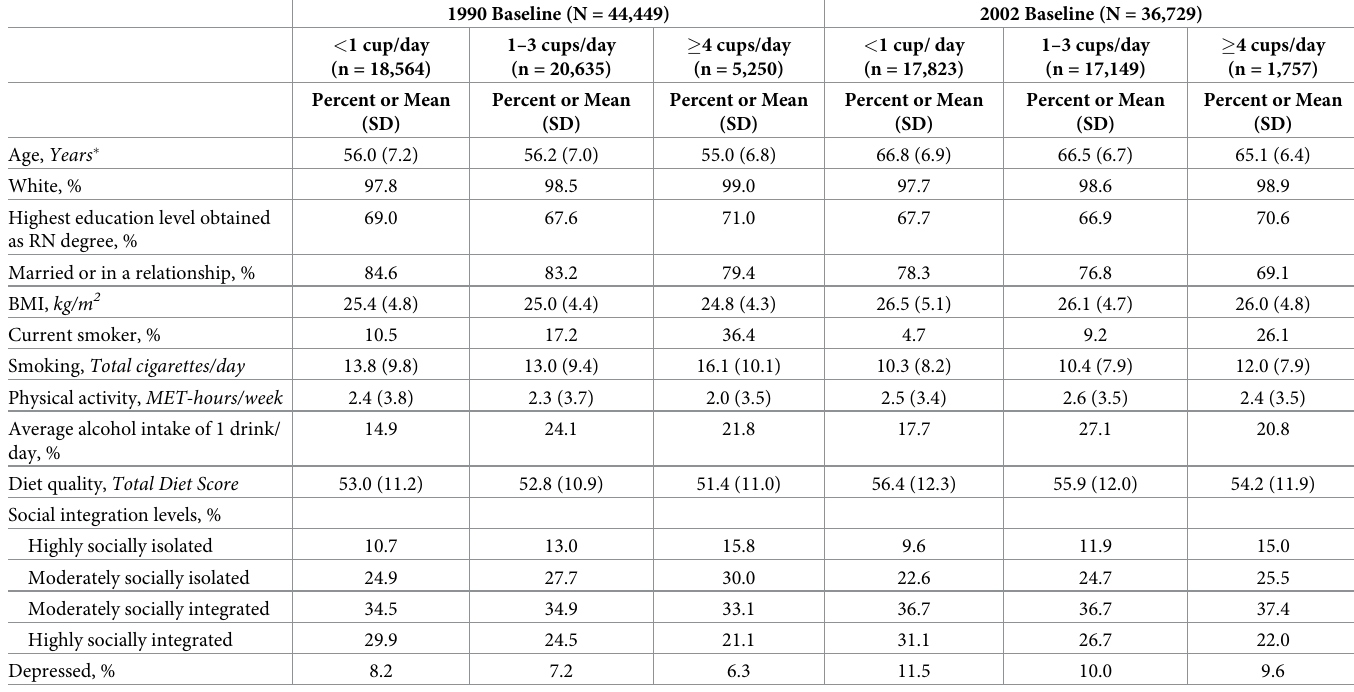
Table 1. Age-standardized characteristics of women across levels of caffeinated coffee consumption at each analytic